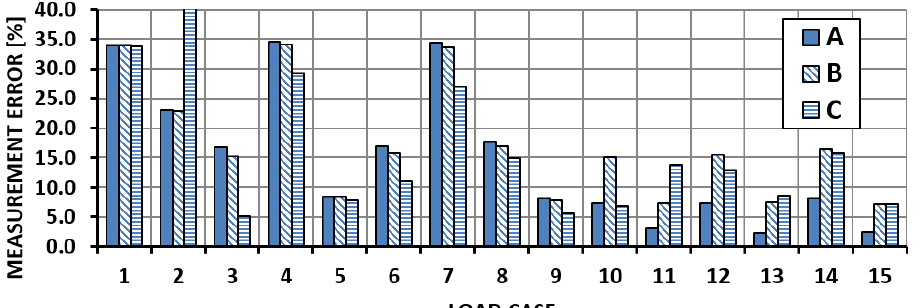
Figure 10. Shear force measurement error—Section III.